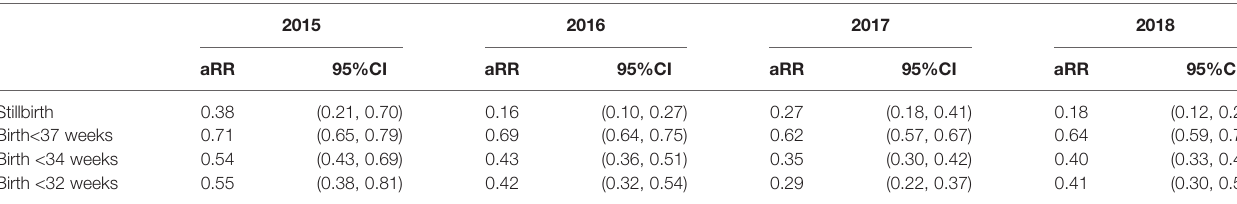
TABLE 5 | Outcome according to